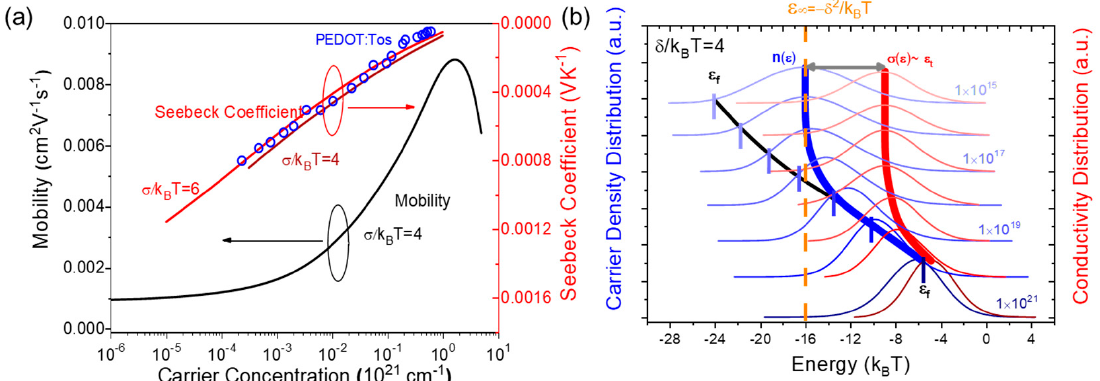
Figure 2. ( a ) Carrier concentration of mobility (black line) and Seebeck coefficient (red lines) in Gaussian disordered organic semiconductor, with fitting data from PEDOT:Tos film (blue circles). ( b ) Schematic of the energy position evolution with carrier concentration for carrier density distribution (blue lines) and conductivity distribution (red lines); orange dashed line indicates the position of equilibrium level, blue dashed line stands for the “main source” from which the carriers are activated, and red dashed lines indicate the transport energy level.